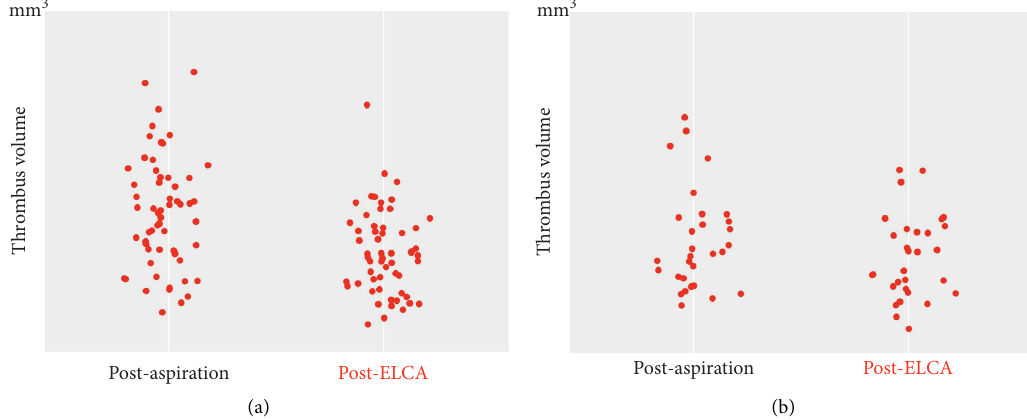
Figure 7: Scatter plots of thrombus volume after manual aspiration thrombectomy and laser vaporization. ELCA, excimer laser coronary angioplasty. (a) Ruptured plaque. (b) Nonruptured